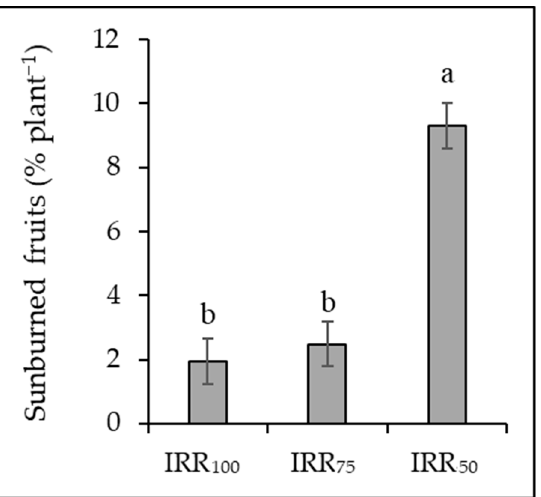
Figure 5. Effect of irrigation treatments on the percentage of sunburned fruits. Different letters indicate significant differences at p < 0.001. Vertical bars represent the standard errors.